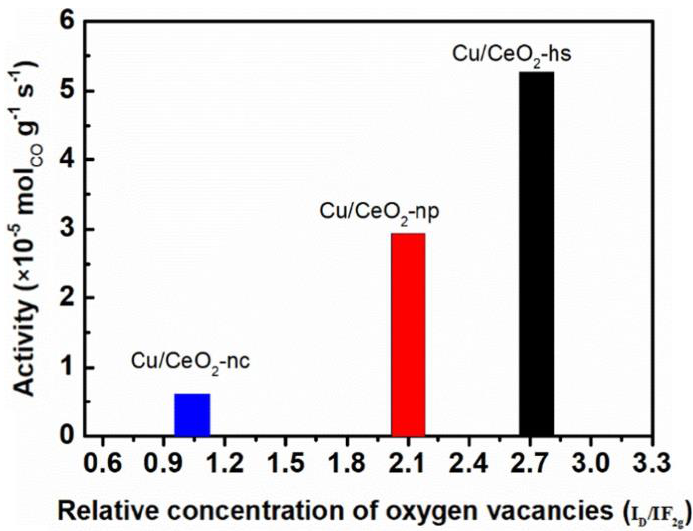
Figure 23. Effect of oxygen vacancies in the rWGS activity over Cu/CeO 2 nanoparticles. Reproduced with permission from Ref. [197]. Copyright© 2020, Elsevier.